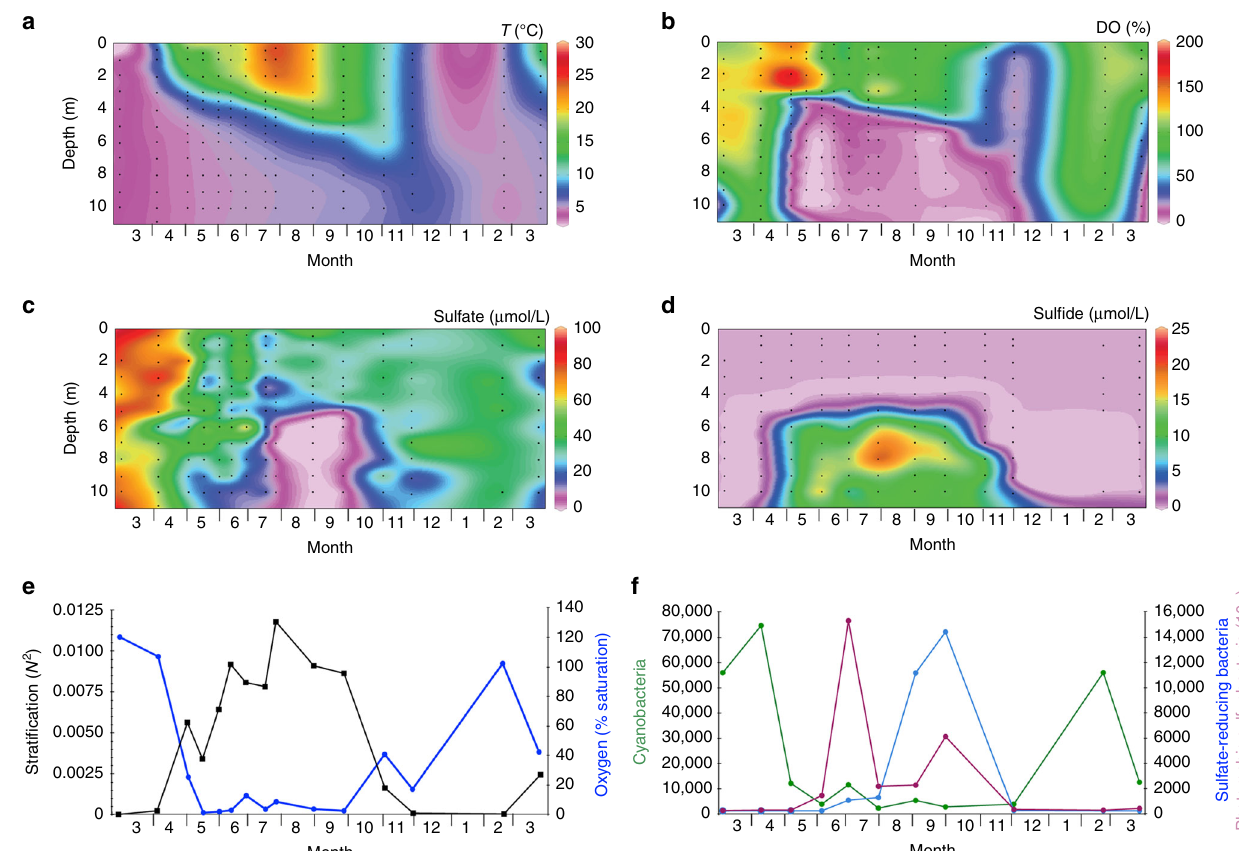
Fig. 5 Data from the seasonally strati fi ed Lake Vechten. Contour plots of seasonal changes in, a temperature; b dissolved oxygen; c sulfate; d sul fi de. The plots are based on 189 water samples ( black dots ) taken from March 2013 to early April 2014. e Seasonal changes of the strength of strati fi cation ( black line , quanti fi ed by the squared buoyancy frequency N 2 at the thermocline) and oxygen saturation just below the thermocline ( blue line , measured at 6 m depth). f Seasonal changes in relative abundances of cyanobacteria ( green line ), phototrophic sulfur bacteria ( magenta line ) and sulfate-reducing bacteria ( light blue line ) in the metalimnion (at 6 m depth), based on 16S rRNA sequence